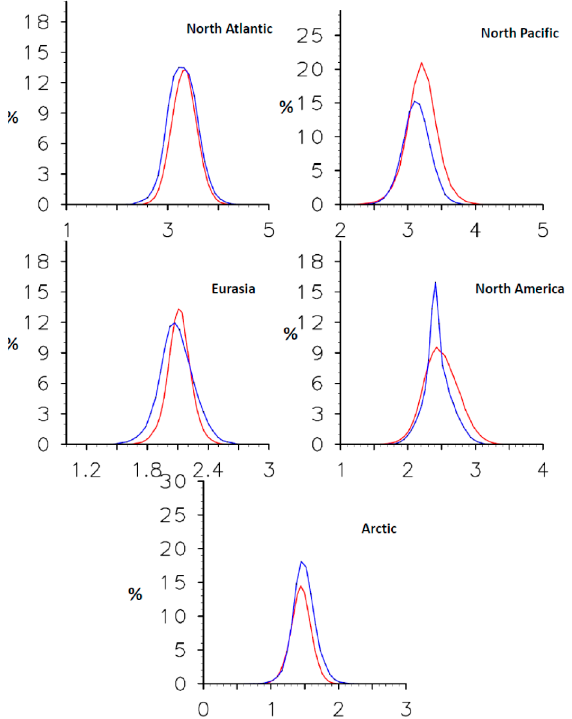
Figure 8. Probability Density Function (PDF) of area averaged Total Precipitation in mm/day (along x -axis) in MAM (spring) for each of the sub-regions. Red lines for Pos (more sea ice years) and blue line for Neg (less sea ice years).